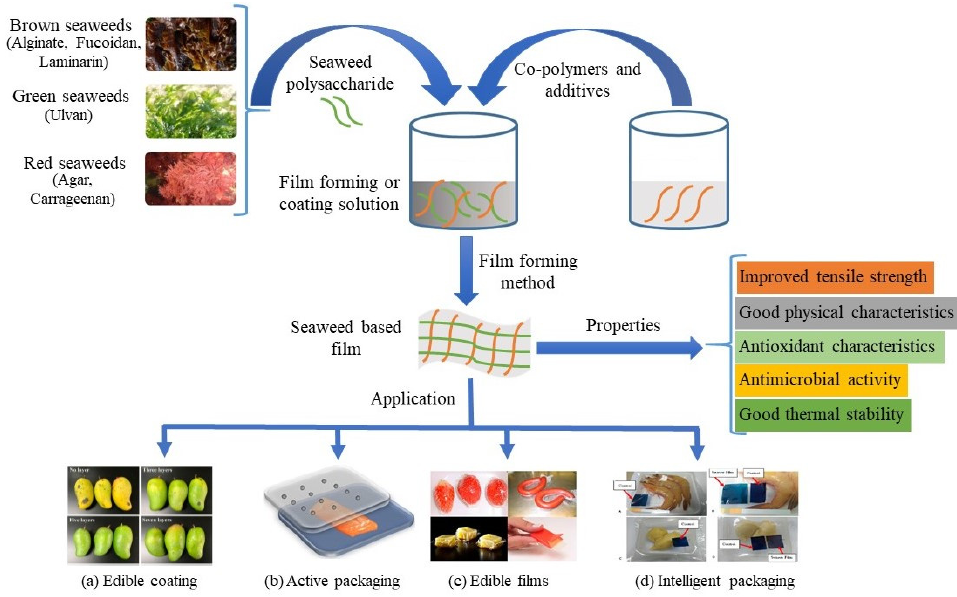
Figure 1. The mechanism for developing seaweed-based food contact materials. ( a ) Mangoes coated in chitosan- and alginate-based coatings enriched with cinnamon essential oil microcapsules [13], ( b ) Active packaging of cold-smoked salmon with Zn-MgO/Alginate film [14], ( c ) Some examples of edible films [15], ( d ) Intelligent packaging of shrimp and durian using ι -carrageenan based colorimetric pH sensor film [16].